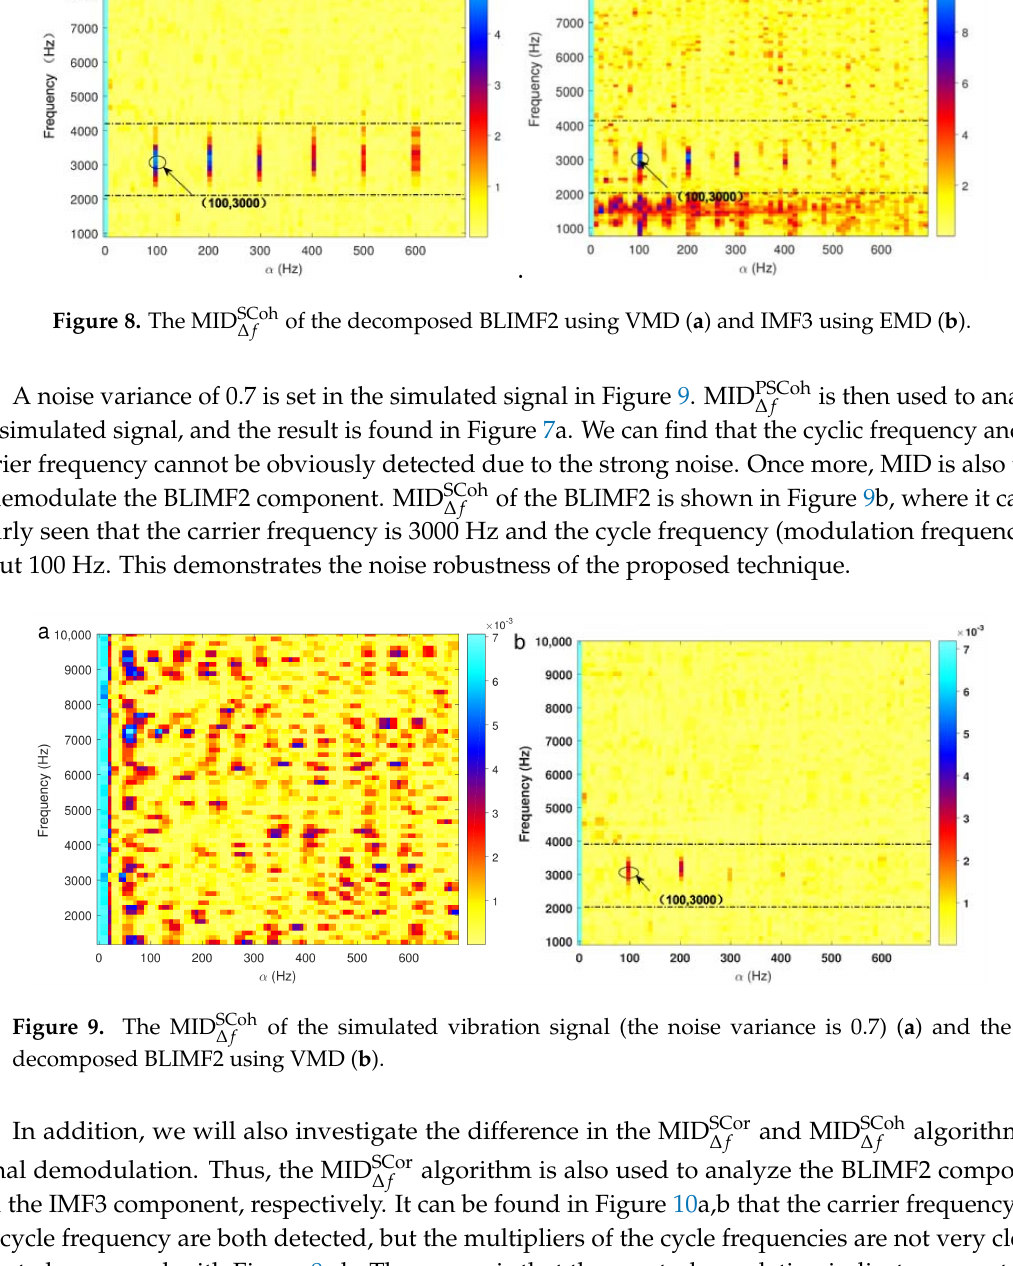
is then used to analyze f